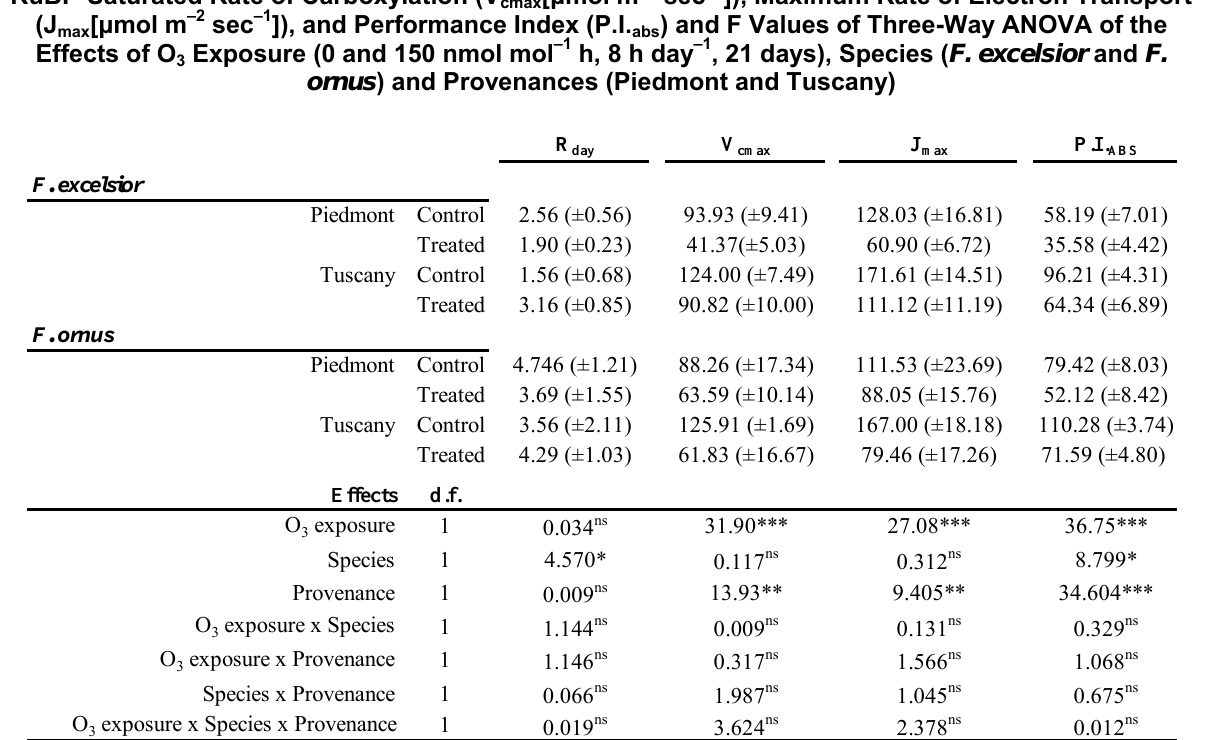
[ μ mol m –2 sec –1 ]), day